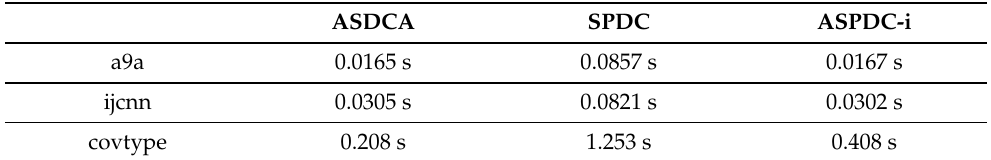
Table 6. The average running time for the algorithms to pass through the entire dataset once when λ = 10 − 6